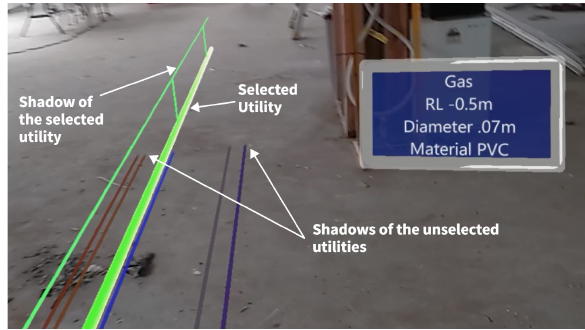
Figure 10. General + Range View